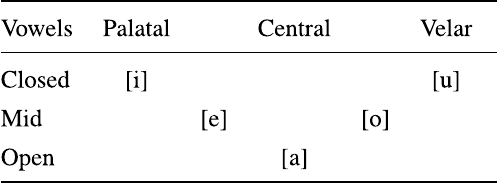
Table 3. Vowels of the Mexbet-22 phonetic alphabet for Mexican